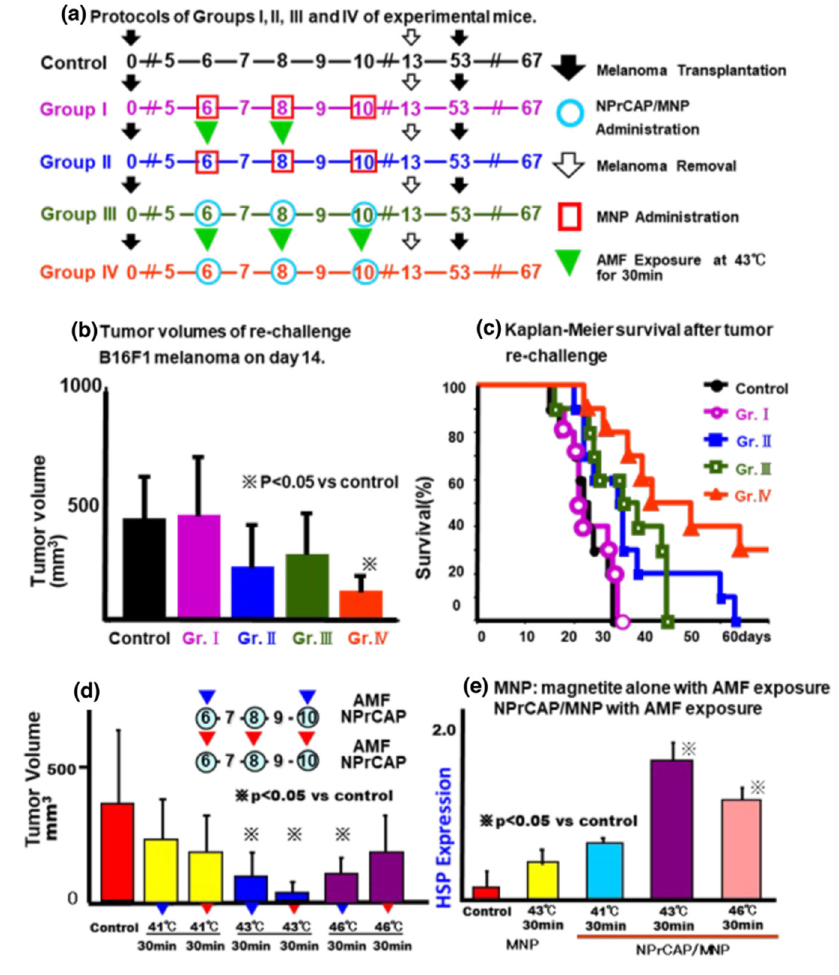
Figure 13. Tumor growth and survival of mice re-challenged with melanoma transplants after treat- ment of initial transplants; heat shock protein (HSP) expression in initial transplants. ( a ) Experi- mental protocols for the five groups of mice, all of which underwent initial B16F1 melanoma trans- plants on day 0, removal of the tumors on day 13, and re-challenge with B16F1 on the opposite